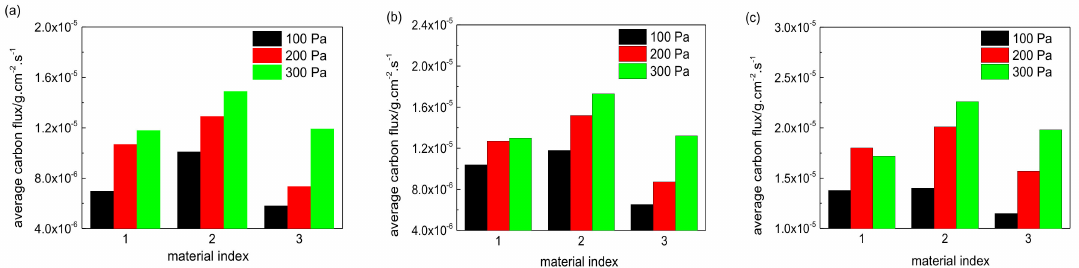
Figure 13. E ff ect of carburizing pressure on average carbon flux of three materials ( a ) 100 Pa; ( b ) 200 Pa; ( c ) 300 Pa.